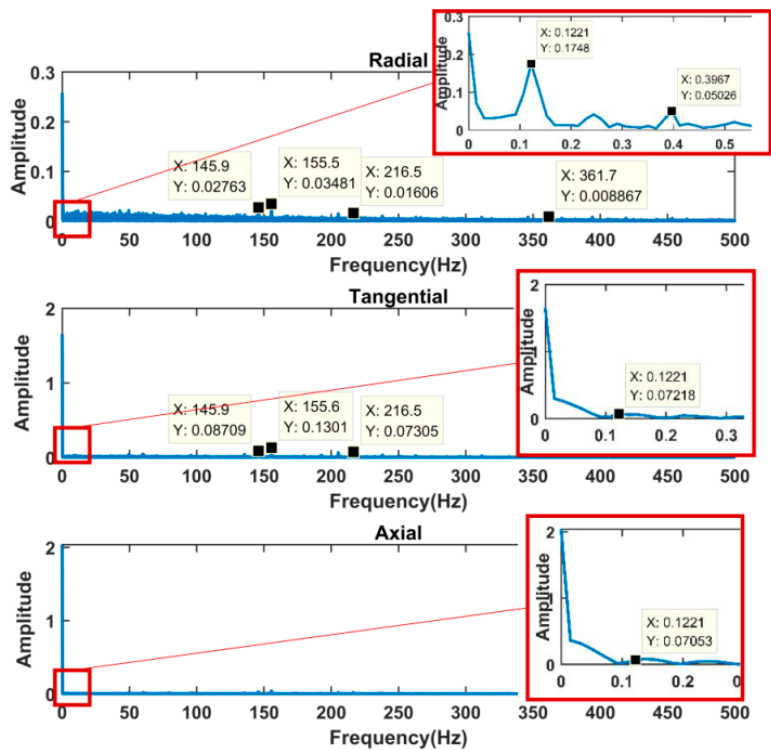
Figure 10. Three-axis acceleration frequency spectrum of stick-slip Figure 10. Three ‐ axis acceleration frequency spectrum of stick ‐ slip vibration.